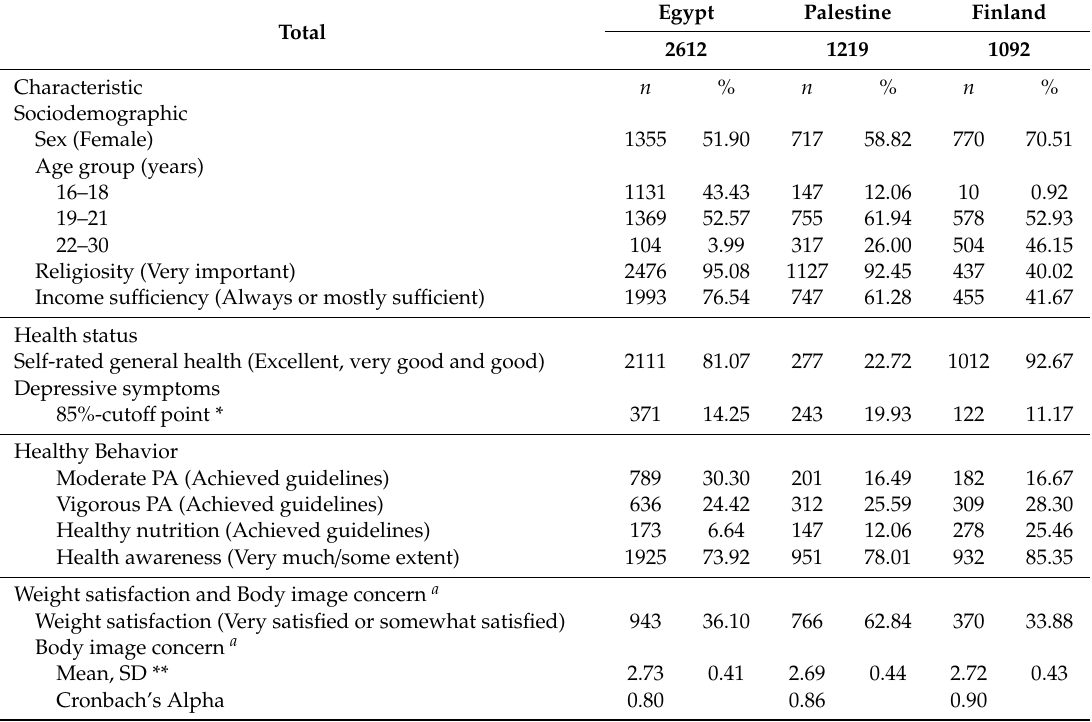
Table 1. Characteristics of the sample by